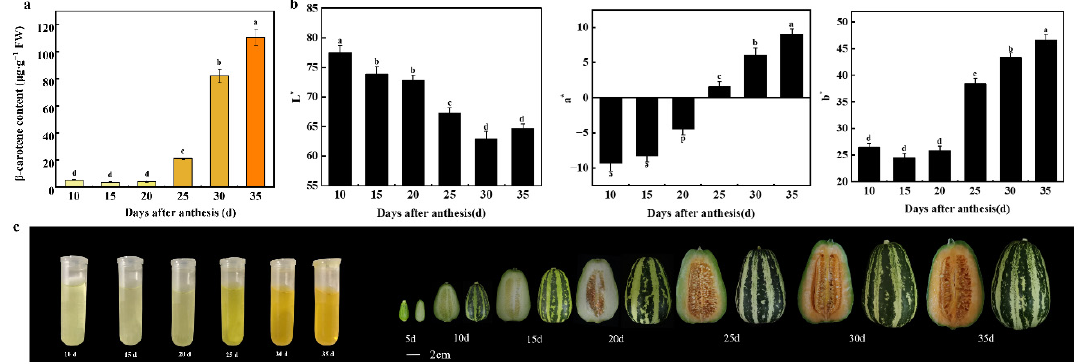
Figure 1. Characterization of fruit flesh in oriental melon. ( a ) β -carotene content of fruit flesh in ‘HDB’ during different development stages. Values represent the mean ± SE of three replicates. Different letters represent a statistically significant difference at the different days after anthesis ( p < 0.05). ( b ) L*, a*, and b* were measured during the fruit development and ripening. Values represent the mean ± SE of three replicates. ( c ) Changes in fruit flesh of ‘HBD’ during different developmental stages.